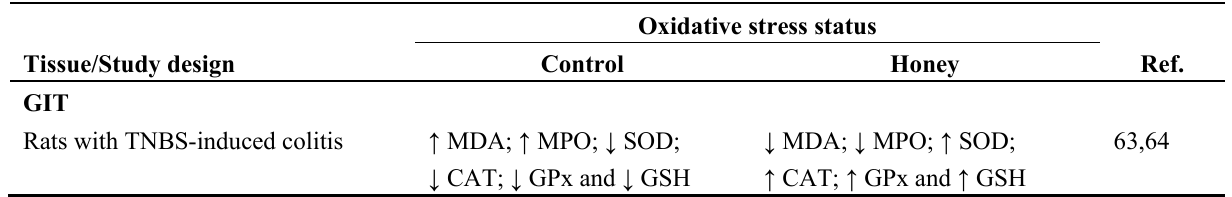
Table 1. Summary of the antioxidant effects of honey in different